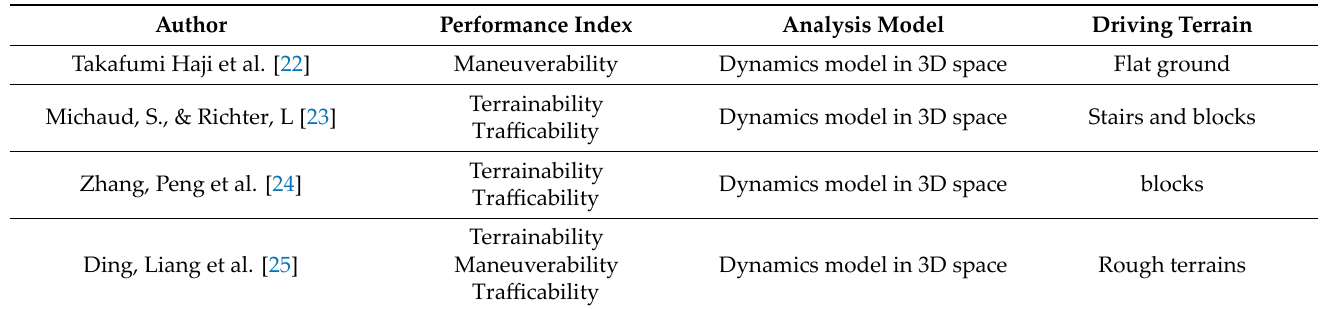
Table 4. Previous works for evaluation of mobile robot